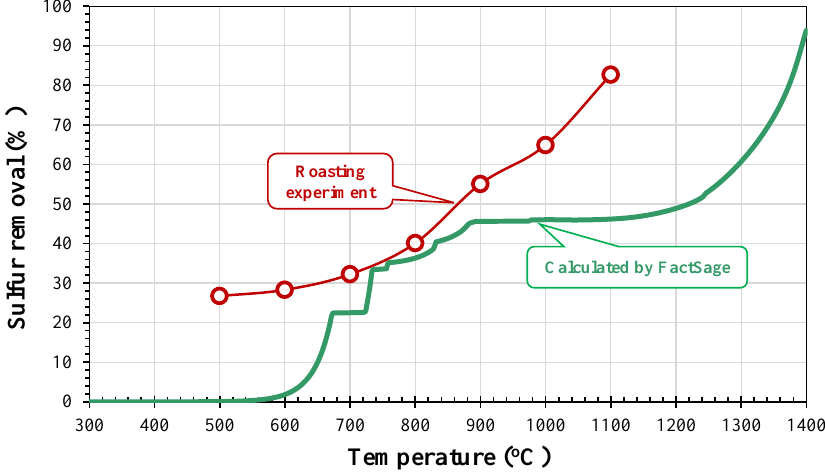
Figure 7. Comparison of sulfur removal efficiency between the roasting experiment and thermo- chemical calculation.